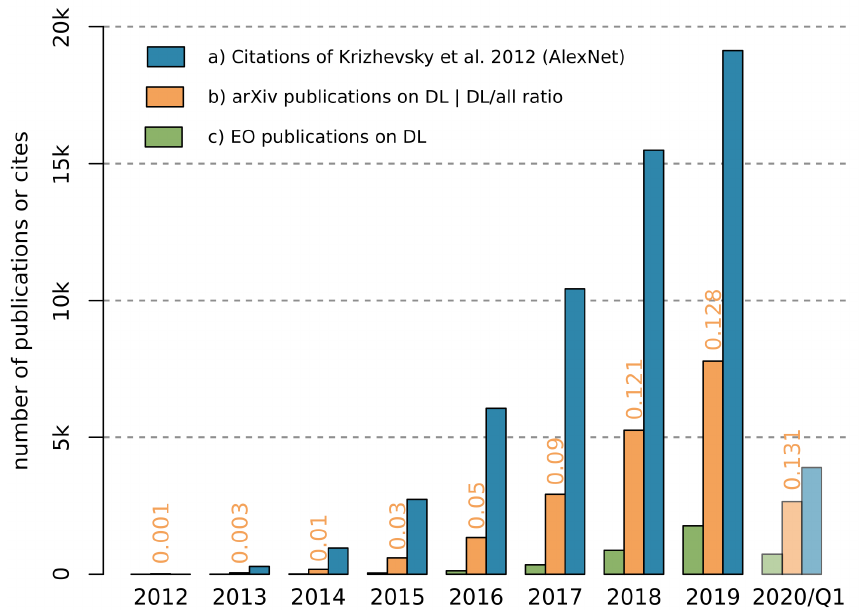
Figure 1. Evolution of deep learning related publications: (a) citations listed in Google scholar for Krizhevsky et al. 2012 [3]; (b) arXiv listed publications in the categories cs and stat including the terms deep learning, convolutional neural networks, convolutional networks or fully convolutional and their share of all publications listed in the two categories; and (c) publications in selected Earth observation journals, searched for with the same terms as in